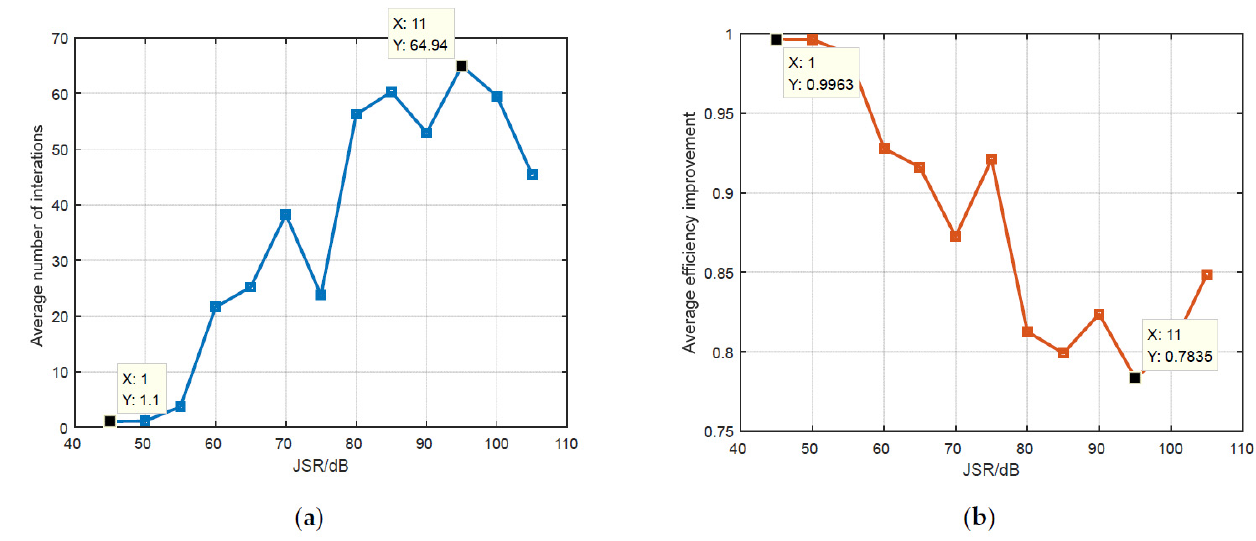
Figure 13. The reasonability of selected iteration step coefficient. ( a ) The relationship between the average iteration number and interference intensities. ( b ) The relationship between efficiency improvements and interference intensities.